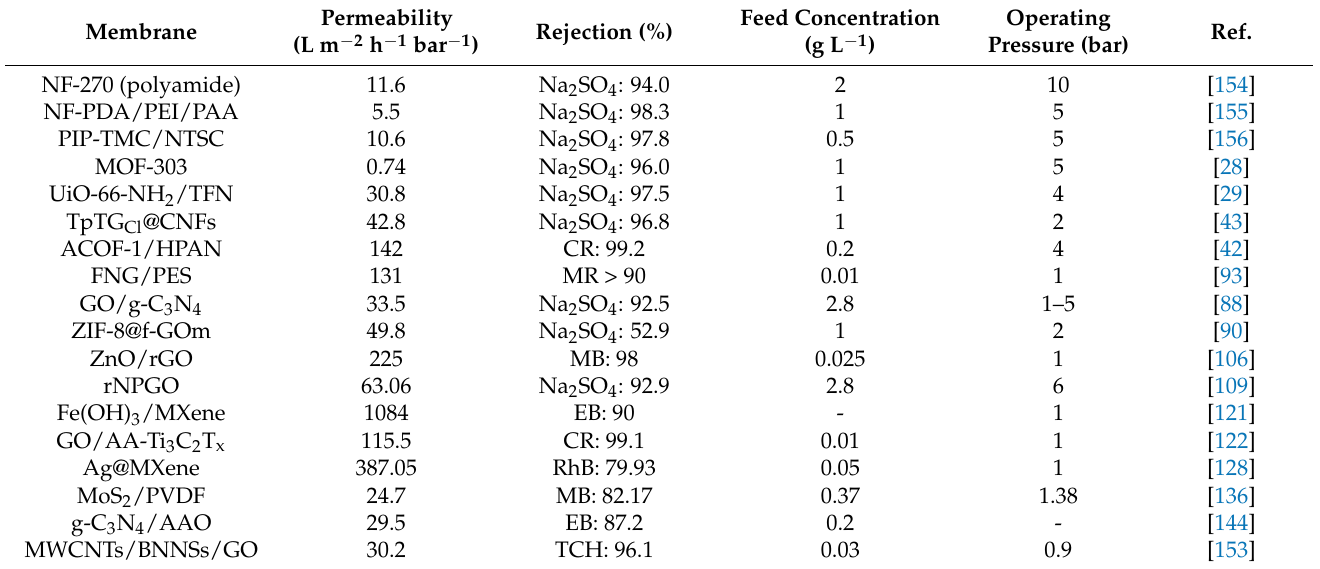
Table 2. Comparison of separation performance of several two-dimensional material membranes and NF